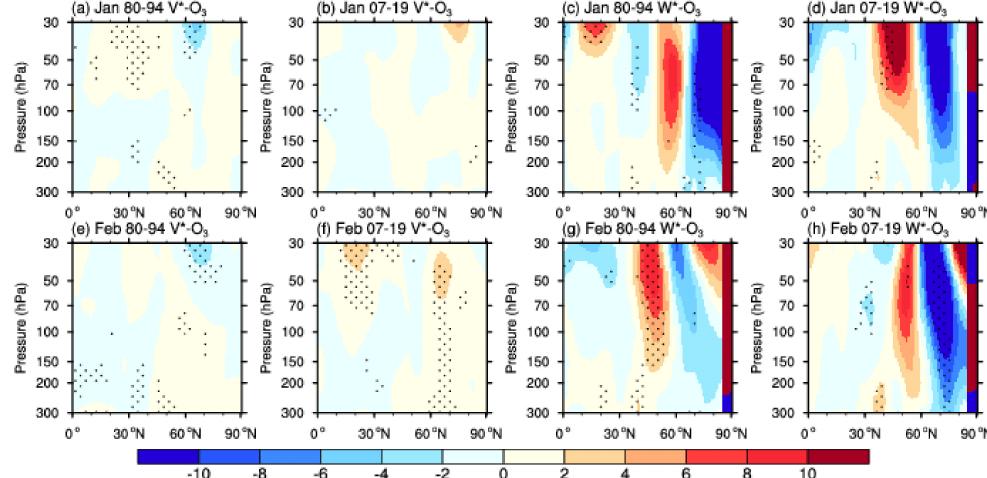
Figure 10. Regression of ozone anomalies ( a , b ) v ∗ -produced (ppbm day -1 ) and ( c , d ) w ∗ -produced (ppbm day -1 ) on AO index in January during ( a , c ) 1980–1994 and ( b , d ) 2007–2019. ( e – h ) Same as ( a – d ), but for the anomalies in February. The values over the stippled regions are statistically significant at the 95% confidence